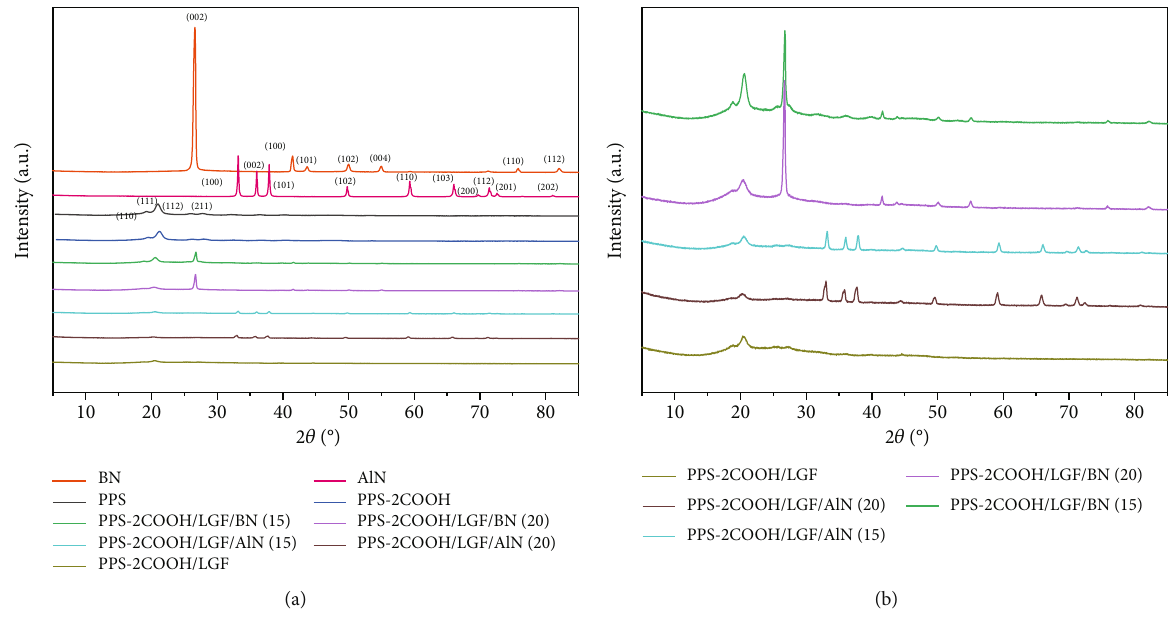
Figure 2: (a) XRD patterns of PPS, PPS-2COOH, BN, AlN, PPS-2COOH/LGF/BN and PPS-2COOH/LGF/AlN; (b) XRD images of the composites.